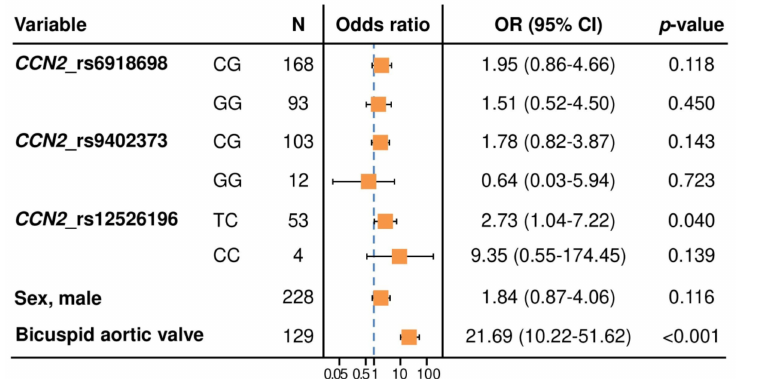
Figure 2. Forest plot showing the multivariable logistic regression model for the association be- tween CCN2 rs12526196 polymorphism and the presence of thoracic aortic aneurysm, adjusted for rs6918698 and rs9402373 polymorphisms and other potential confounders selected with the Akaike information criterion. Reference for CCN2_rs6918698 polymorphism: CC genotype. Reference for CCN2_rs9402373 polymorphism: CC genotype. Reference for CCN2_rs12526196 polymorphism: TT genotype. Reference for sex: female. Reference for bicuspid aortic valve: tricuspid aortic valve. N = number of patients. OR (95% CI): Odds ratio (95% confidence interval).